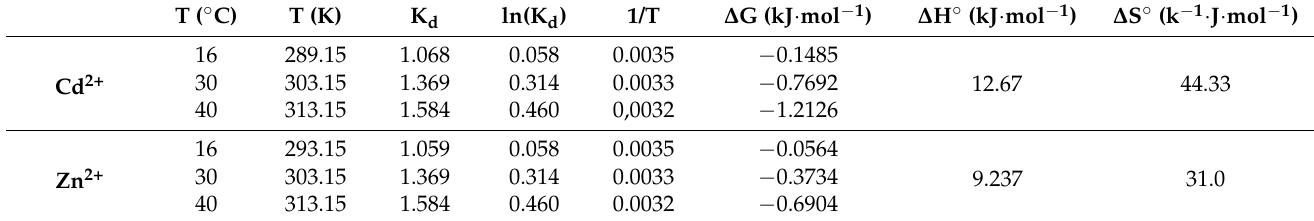
Table 3. Thermodynamic parameters of Cd 2+ and Zn 2+ adsorption on HAp/CTs 20/80 composite.